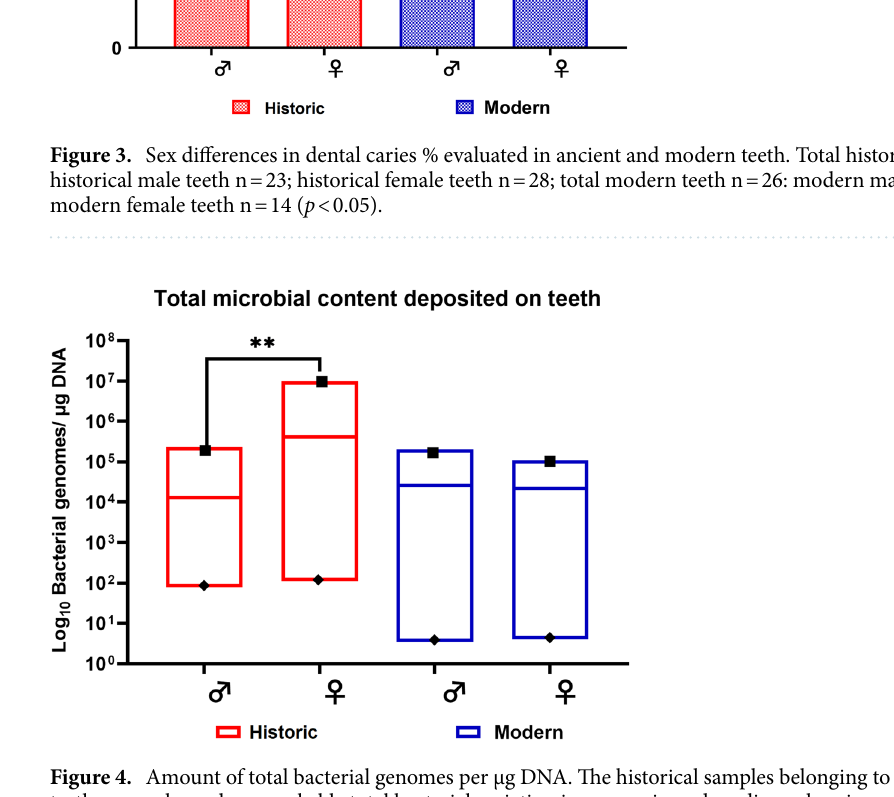
Figure 4. Amount of total bacterial genomes per µg DNA. The historical samples belonging to the females’ teeth group showed a remarkable total bacterial variation in max–min and median values in comparison